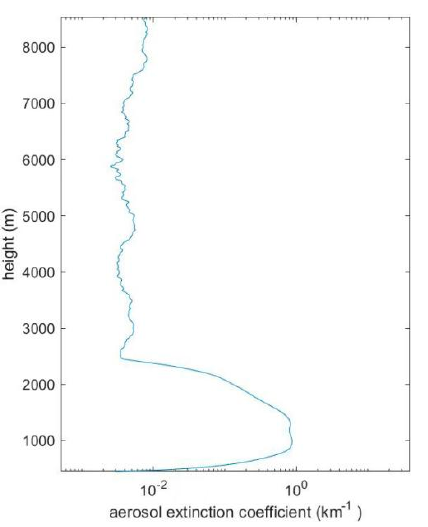
Figure 4. Aerosol extinction coefficient on 29 January 2021, 2:00 am, local time. The timely distribution of aerosol coefficient at different times and heights is shown in Figures 5 and 6. In both Sansha and Hefei, with the increase in altitude, aerosol extinction coefficient decreases. The line between dark blue and bright blue in the pseudo-color map roughly represents a rapid aerosol concentration decrease in the upper air. The line is especially obvious in Figure 6. The dark blue stands for lower aerosol concentration while light blue represents higher aerosol concentration. In winter, this concentration decrease line in Hefei is around 2 km, while the line in Sansha is slightly above 4 km. This is due to the temperature difference. The latitude of Sansha (16 ◦ 50 (cid:48) N) is lower that Hefei (31 ◦ 51 (cid:48) N), so the temperature in Sansha is higher during winter. Furthermore, the rise in atmosphere temperature will result in atmosphere expansion and a rise in the concentration decrease